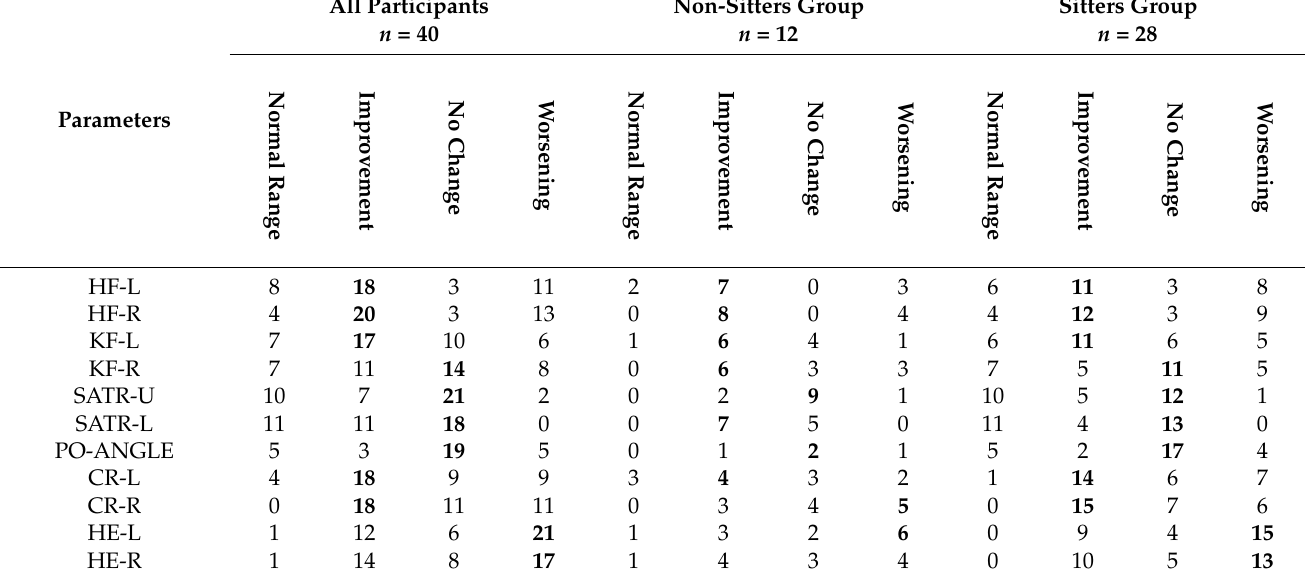
Table 3. The changes in the structural assessment of the musculoskeletal system, divided according to the scale used for the study. The numbers of children in whom the baseline value was correct and did not worsen (normal range), a previously abnormal range improved, the range remained abnormal (no change), or a worsening occurred, were all